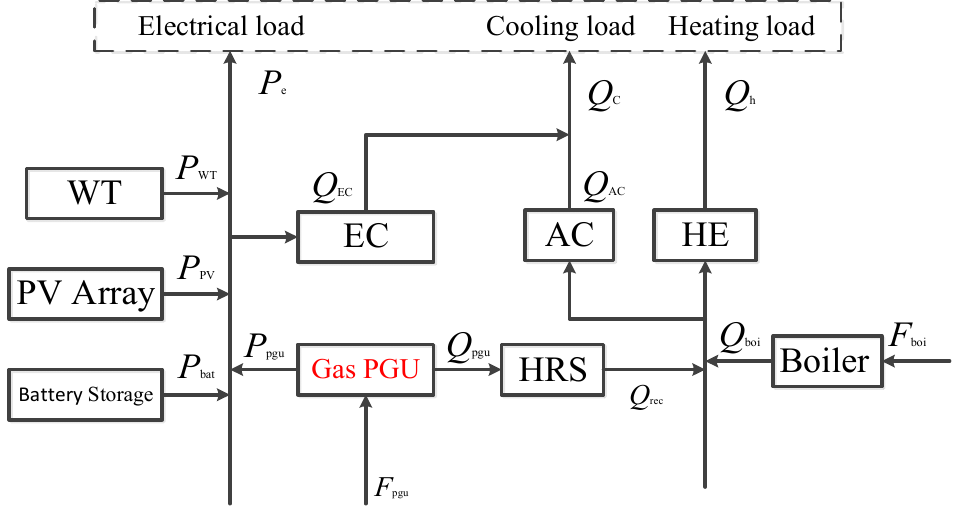
Figure 1. Structure of microgrid with CCHP.